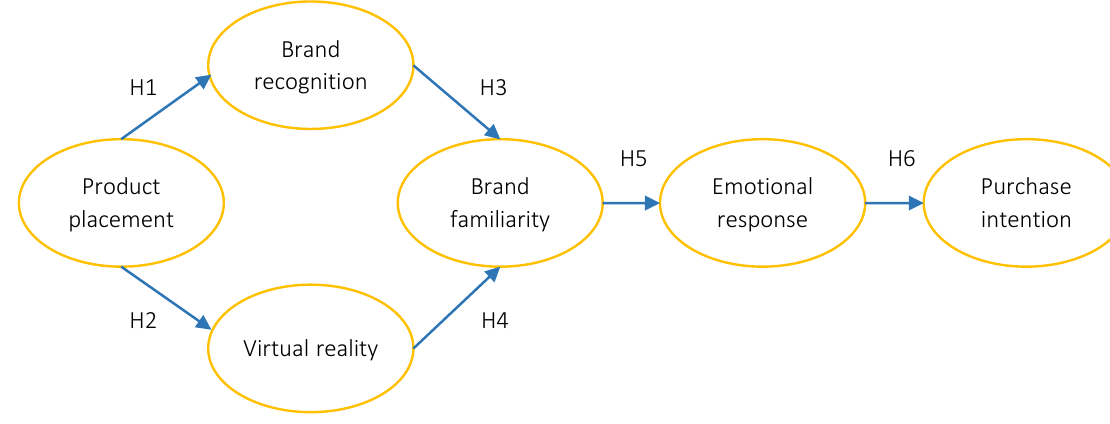
Figure 1. Conceptual model and